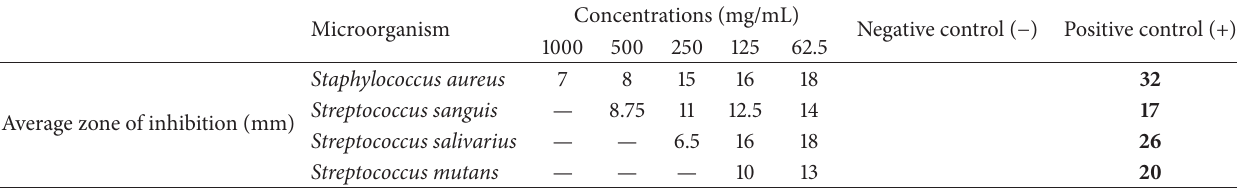
Table 2: Average of inhibition zone of ethanolic extract on bacteria (mm).